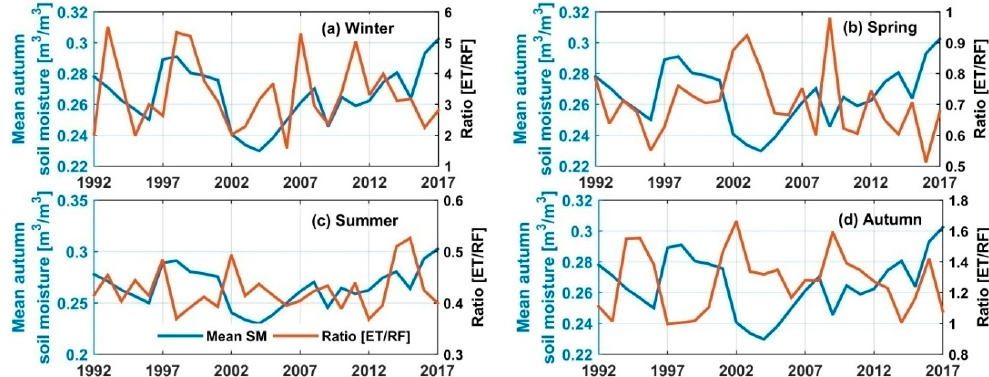
Figure 15. The effects of ( a ) winter, ( b ) spring, ( c ) summer, and ( d ) autumn rainfall (RF) and evapotranspiration (ET) (expressed as ET/RF ratio) on the temporal distribution of ASM in the UBNB from 1992 to 2017.